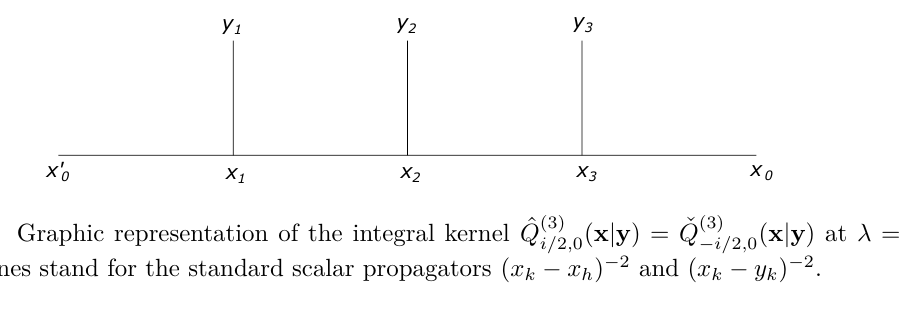
( x | y ) at λ = − i . − i/ 2 , 0 ) − 2 . k − y k